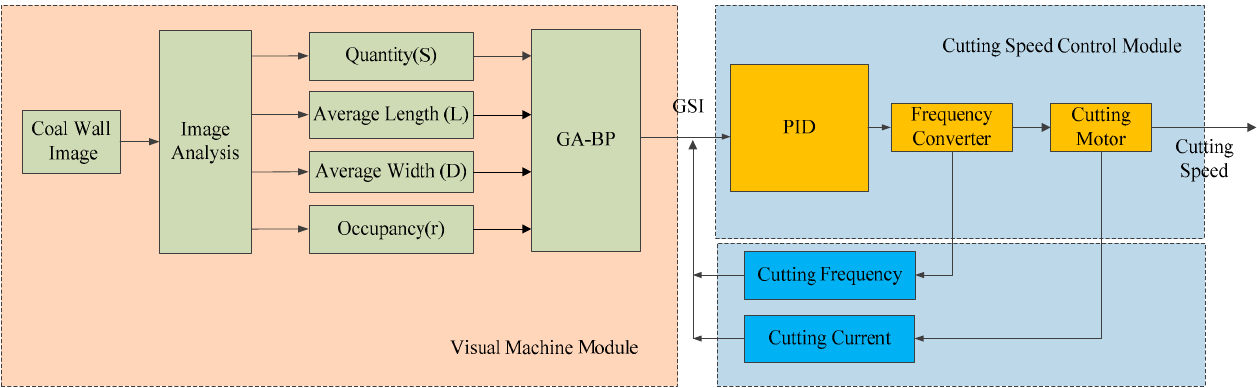
Figure 8. Adaptive cutting control strategy.